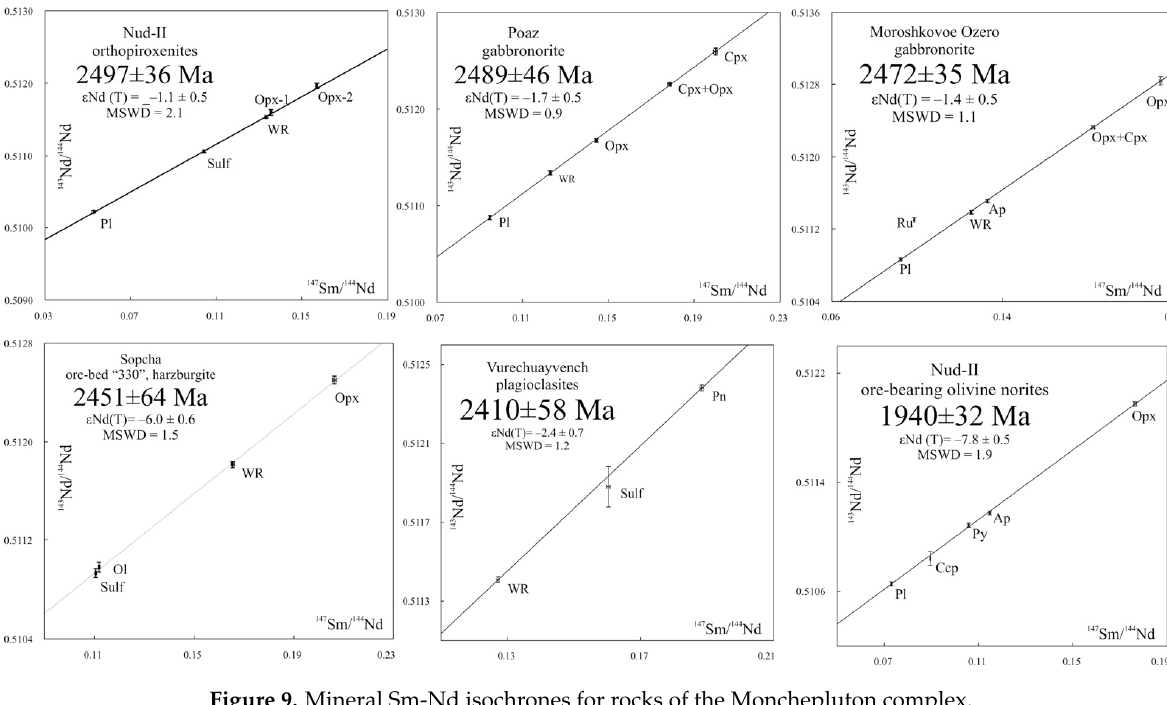
Minerals 2021 , 11 , x FOR PEER REVIEW 18 of 25